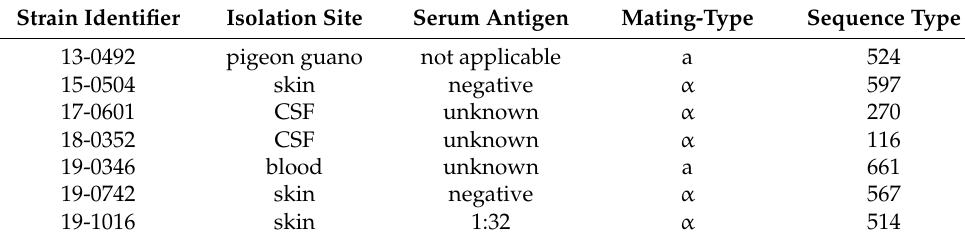
Table 1. C. neoformans var. neoformans strains isolated in Germany used in this